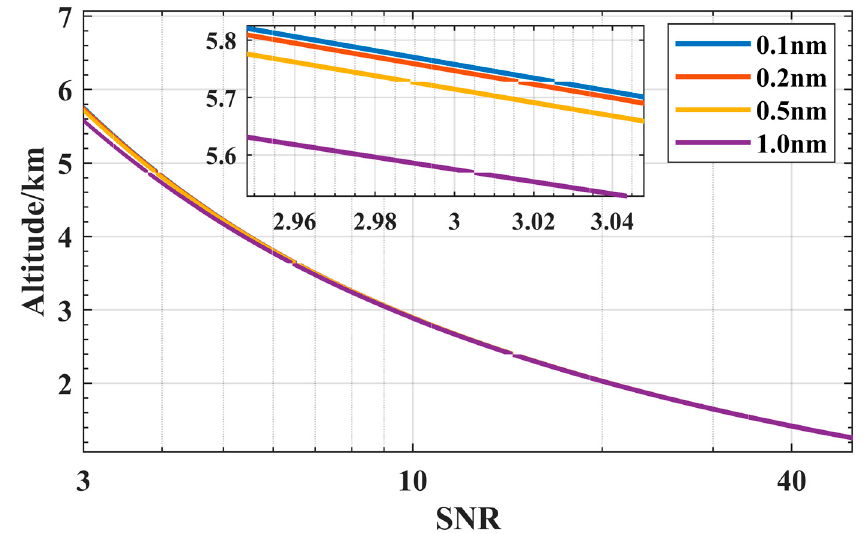
Figure 5. SNR curves of lidar corresponding to different filter bandwidth: 0.1 nm (blue), 0.2 nm (yellow), 0.5 nm (red), 1.0 nm (black).